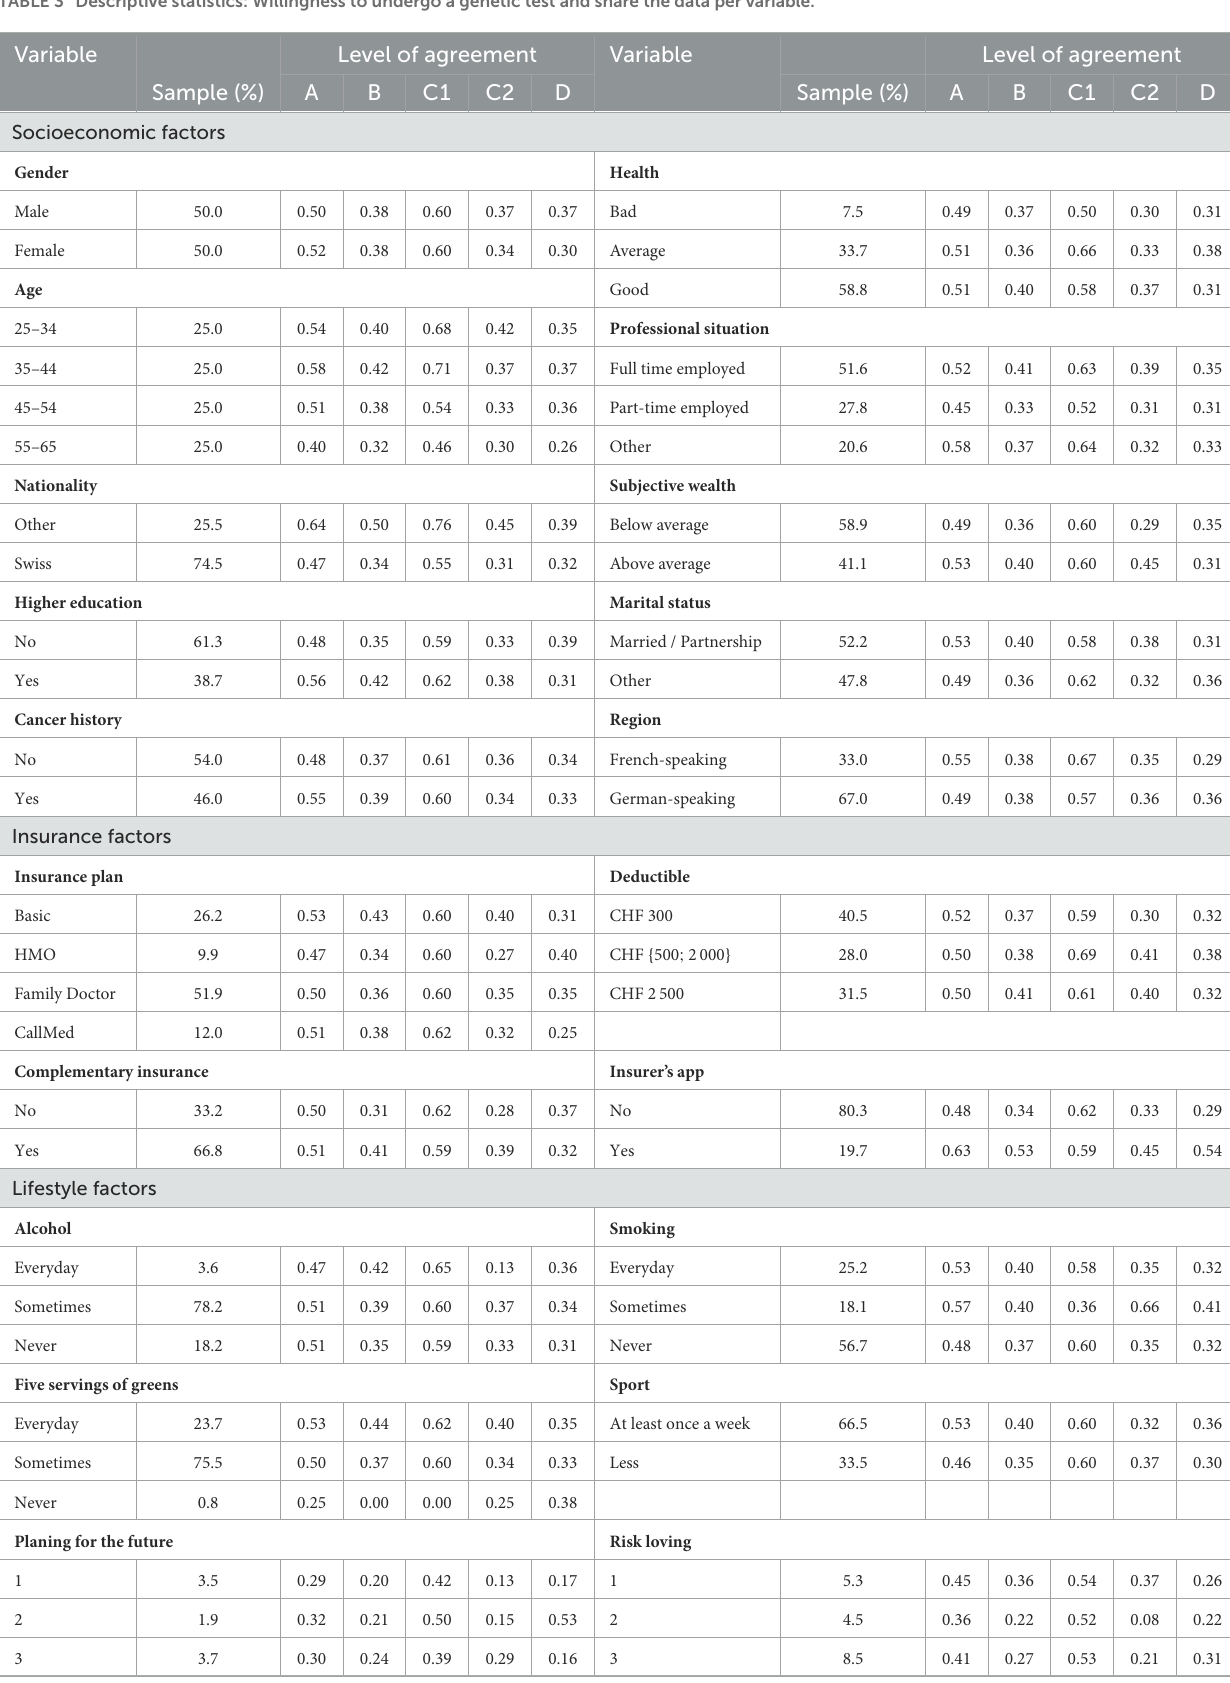
TABLE 3 Descriptive statistics: Willingness to undergo a genetic test and share the data per variable. Variable Level of agreement